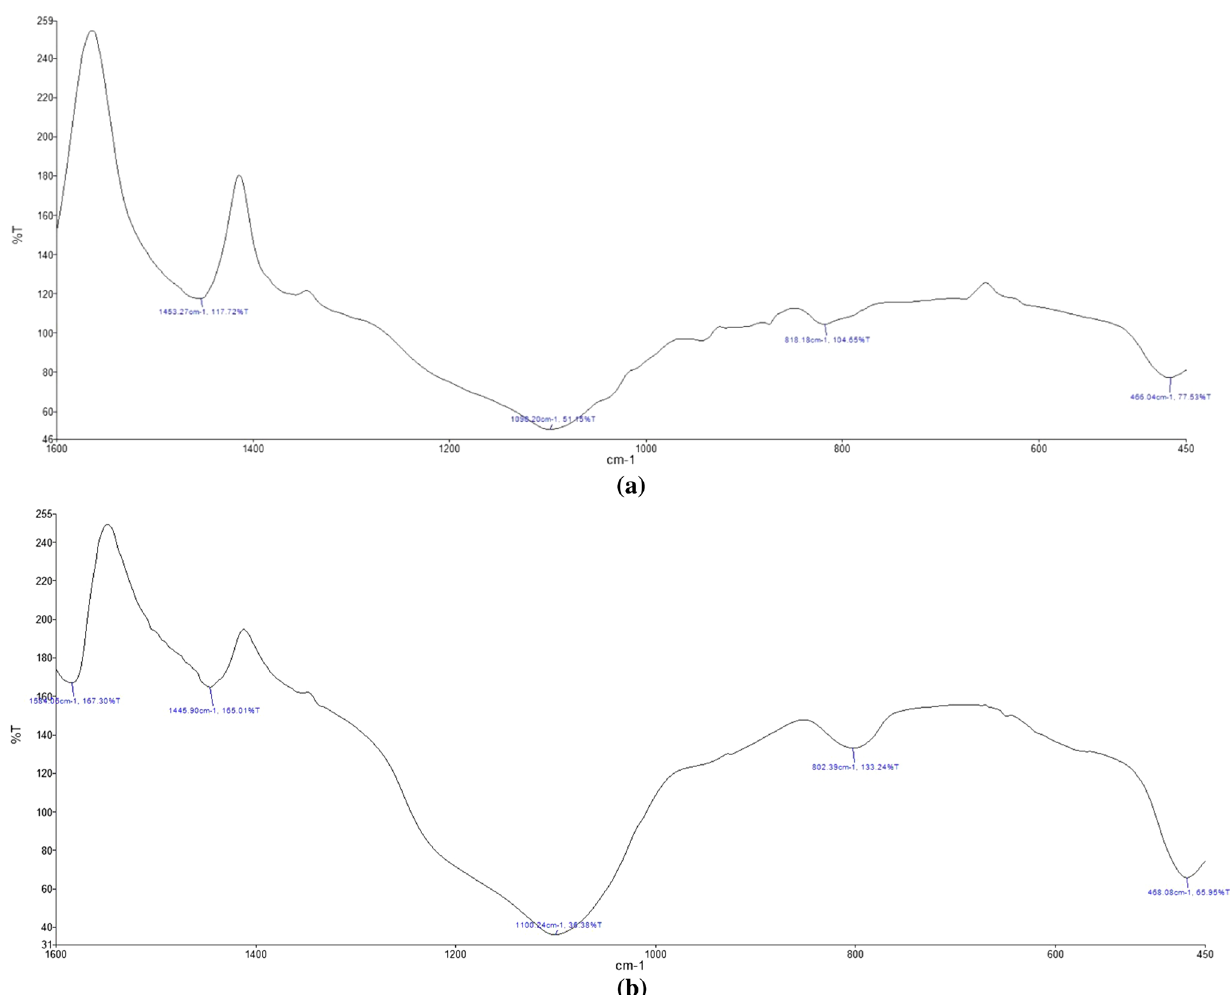
Fig. 2 FTIR spectra for BISAB ( a ) before and ( b ) after fluoride